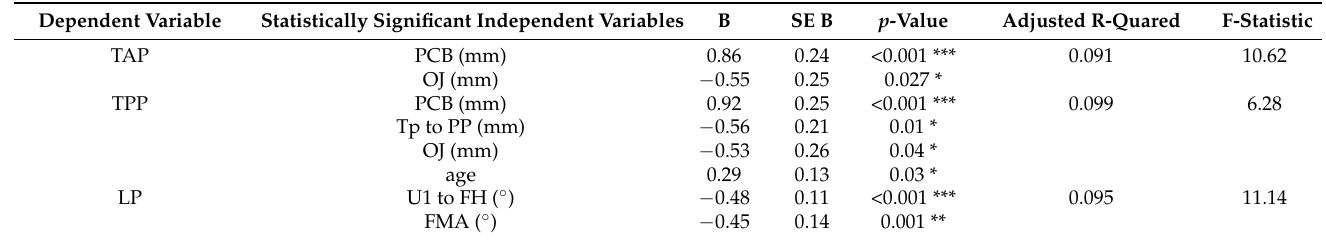
Table 6. Stepwise multiple regression analysis for the perioral muscle force.